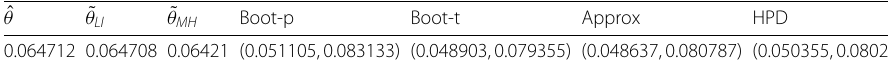
Table 8 Point and interval estimates of θ from data set